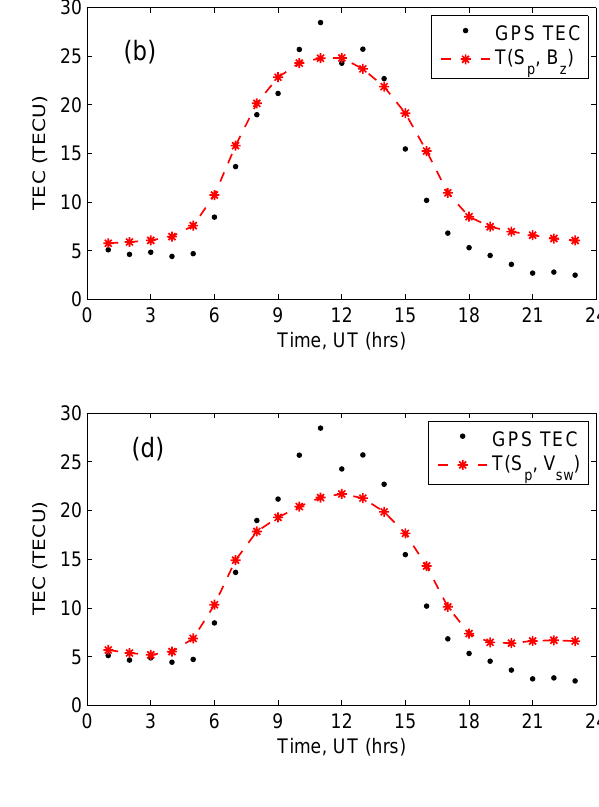
Fig. 4. Similar to Fig. 3, for day 104 in